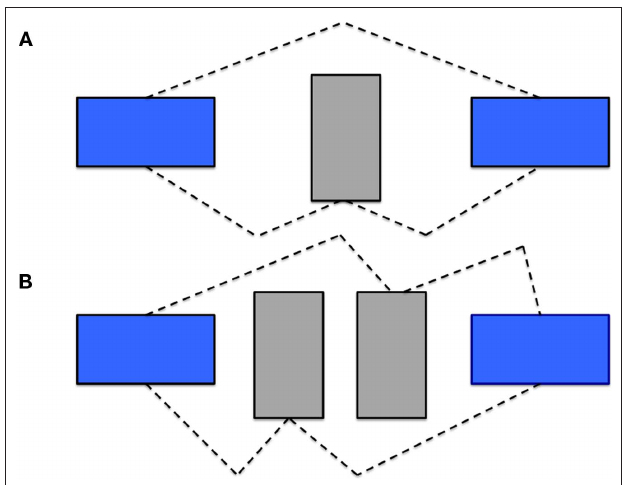
FiguRe 1 | Types of Aeu events. In detecting AEU events, one can identify both (A) cassette exon events and (B) mutually exclusive exon events. The dashed line indicates the transcript structure.